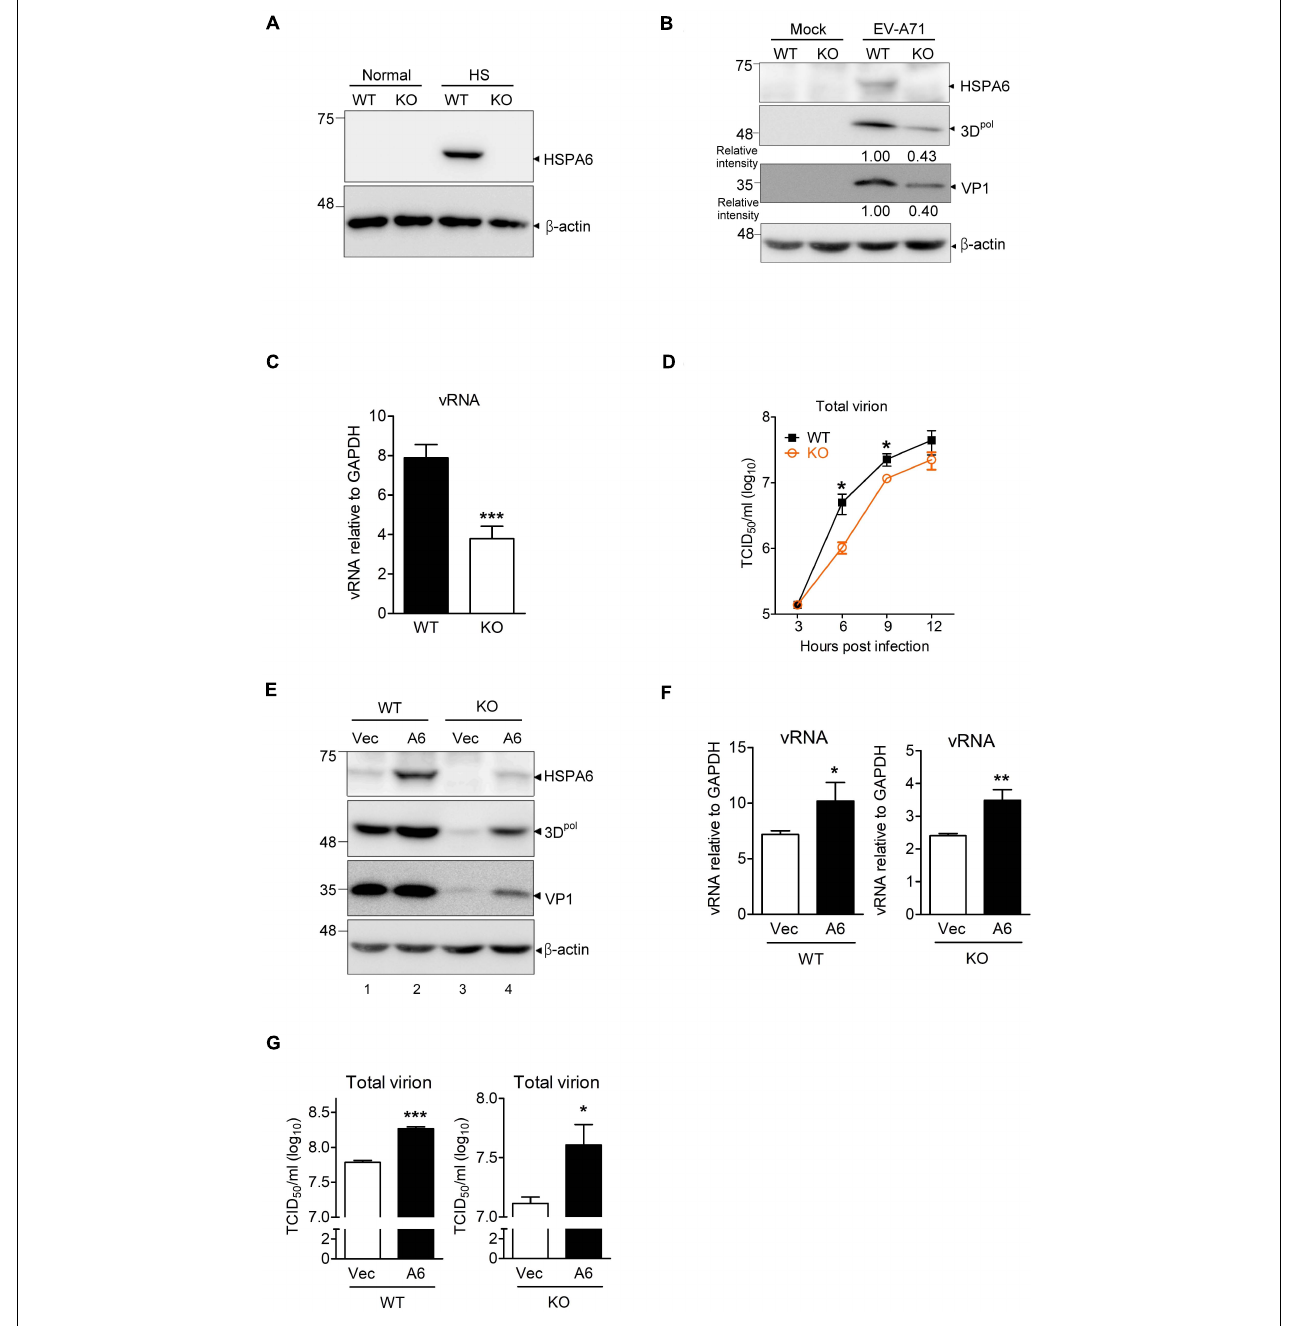
FIGURE 2 | HSPA6 is a positive regulator for EV-A71 cycle. HSPA6 KO RD cells were generated using the CRISPR/Cas9 approach. (A) HSPA6 protein production was examined in WT RD and HSPA6 KO RD cells cultured in normal condition (37 ◦ C) or heat shock condition (42 ◦ C) for 2 h. (B–D) The WT RD and HSPA6 KO RD cells were infected with EV-A71 (MOI = 5). Cell lysates were prepared for the analyses of (B) HSPA6 and viral proteins 3D pol and VP1, and (C) cell-associated vRNA at 6 hpi. (D) Total virion were prepared from culture supernatant and cell lysates collected at 3, 6, 9, and 12 hpi and then titrated. (E–G) WT RD and HSPA6 KO RD cells were transfected with vector control (Vec) or Flag-HSPA6 expressing plasmid (A6) (0.2 µ g/6 × 10 5 cells). 24 h post transfection, cells were infected with EV-A71 (MOI = 5) and harvested for the analyses of (E) viral proteins 3D pol and VP1, (F) cell-associated vRNA at 6 hpi, and (G) total viral titer at 12 hpi. Protein production was measured by Western analysis using specific antibody indicated. HSPA6 mRNA and vRNA were measured by RT-qPCR and normalized with GAPDH mRNA. Viral titer was determined by a 50% tissue culture infective dose (TCID 50 ) assay. Data were presented as means ± SD ( n = 3) and compared with unpaired Student’s t -test. *** P < 0.001, ** P < 0.01, and * P < 0.05.